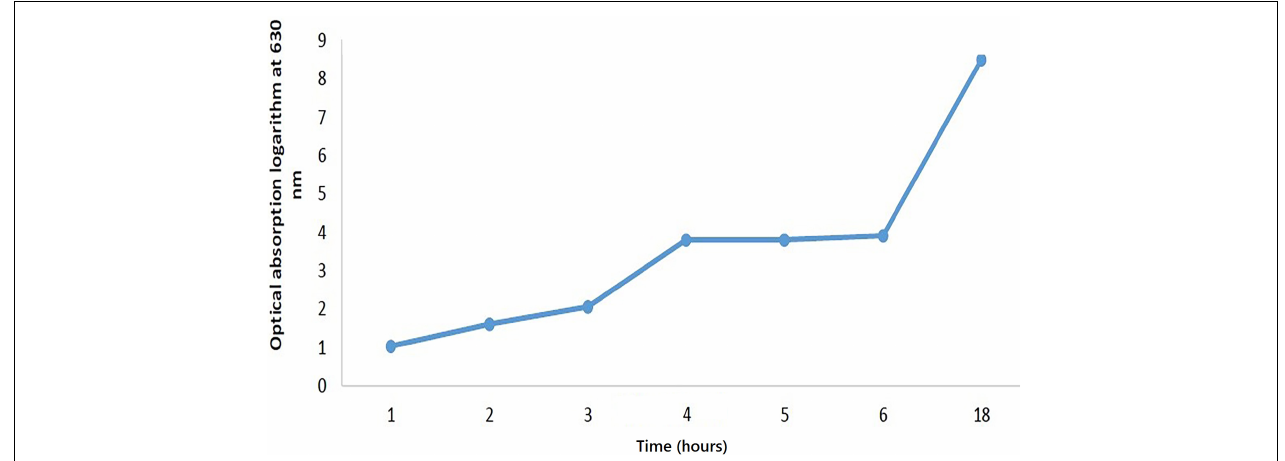
FIGURE 1 | Bifidobacterium lactis growth curve.